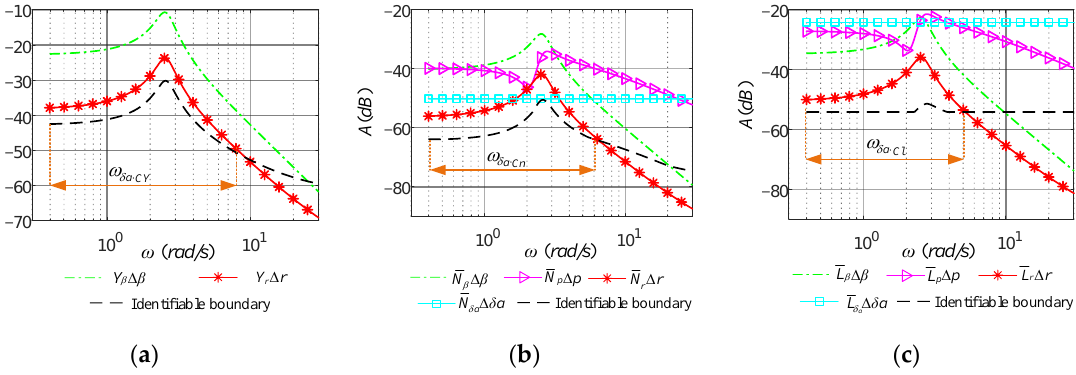
Figure 16. Amplitude–frequency characteristics of lateral-directional aerodynamic parameters varying with aileron frequency. ( a ) Side force; ( b ) Yawing moment; ( c ) Rolling moment. The Dutch roll mode frequency of the test model at V = 30 m/s and α = 6° flight state is approximately 2.5 rad/s. The resonance peaks of the amplitude–frequency characteristic curves of the aerodynamic parameters in Figures 15 and 16 are approximately equal to the Dutch roll mode frequency. The frequency band ranges of the rudder excitation signals tives determined by the method presented in Section 3 are ω δr · Cn = [1.1, 5.3] rad/s, ω δr · Cl = [0.7, 8.7] rad/s, and ω δr · CY = [0.8, 12.0] rad/s, respectively. Taking the intersection of ω δr · Cn ,